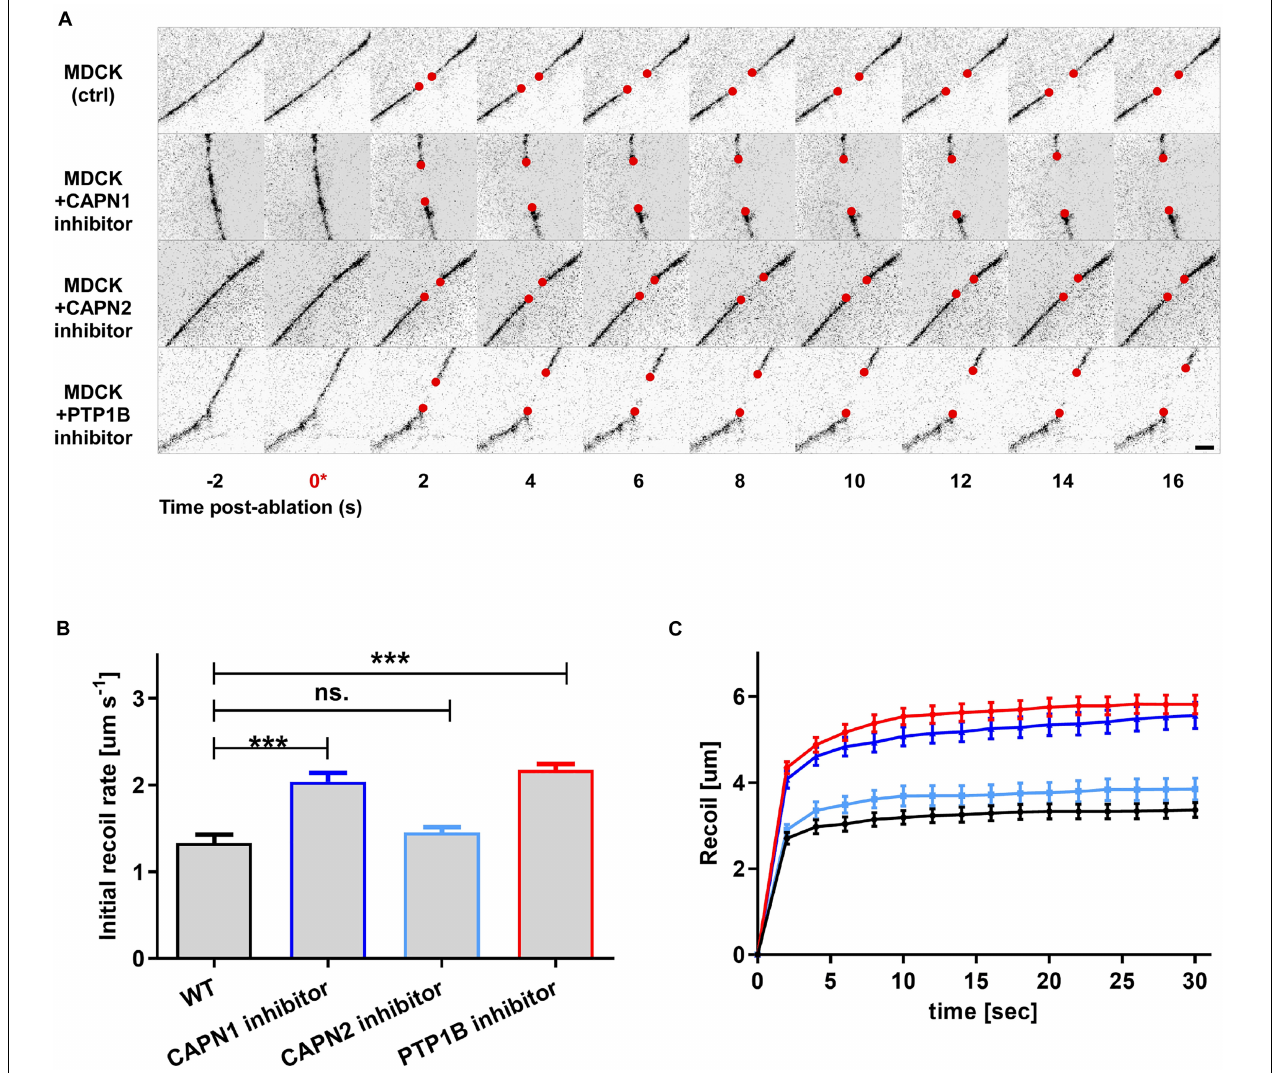
FIGURE 5 | Integration of biochemical signals by the vinculin molecular clutch is regulated by PTP1B dephosphorylation, modulated by calpain cleavage. MDCK cells were cultured on fibronectin-coated substrate to form confluent monolayers, with cell–cell contacts labeled by ZO1-mEmerald. Cells were treated with pharmacological inhibitors as indicated. (A) Montage of consecutive frames (interval: 2 s) shown with junction excision at t = 0 s (asterisk). Recoiling edges of the junctions (red circles) were used to quantify the recoil trajectory in (B,C) . Untreated MDCK (ctrl) were compared with MDCK cells treated with calpain 1 (CAPN1) inhibitor (ALLN, 50 µ M for 1 h), calpain 2 (CAPN2) inhibitor (ALLM, 50 µ M for 1 h), and PTP1B inhibitor (RK682, 10 µ g/ml for 1 h). Scale bar, 5 µ m. Junction recoil (B) and initial recoil rate (C) upon laser ablation of native cell–cell junctions in MDCK epithelial monolayer (wt) and with the indicated pharmacological treatments. Colors of plots in (C) correspond to bar graphs in (B) . Ablation occurred at 0 s. Images were acquired by Nikon A1R MP laser scanning confocal microscope with 60x obj 1.49 NA. Error bars: S.E.M. n values: 15 (ctrl); 17 (+ RK682); 17 (+ ALLN); 11 (+ ALLM). *** P <